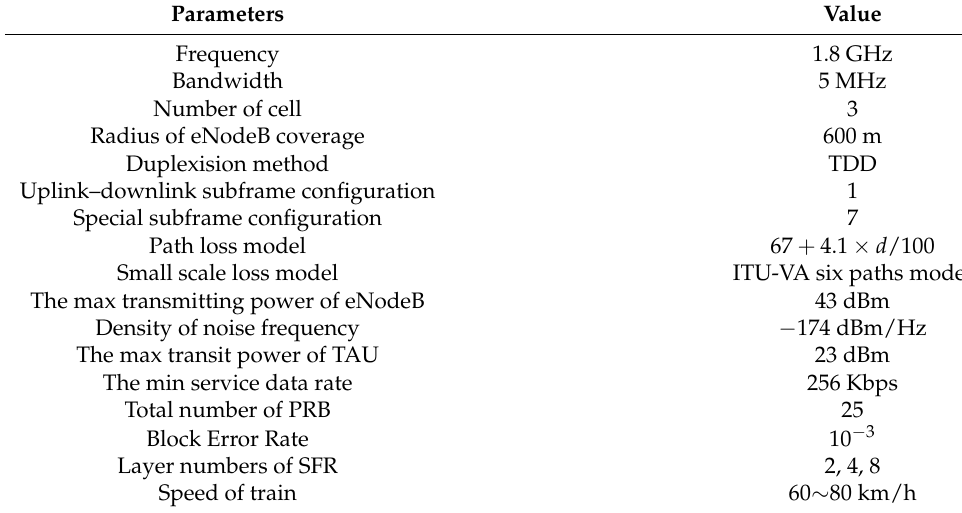
Table 1. Simulation